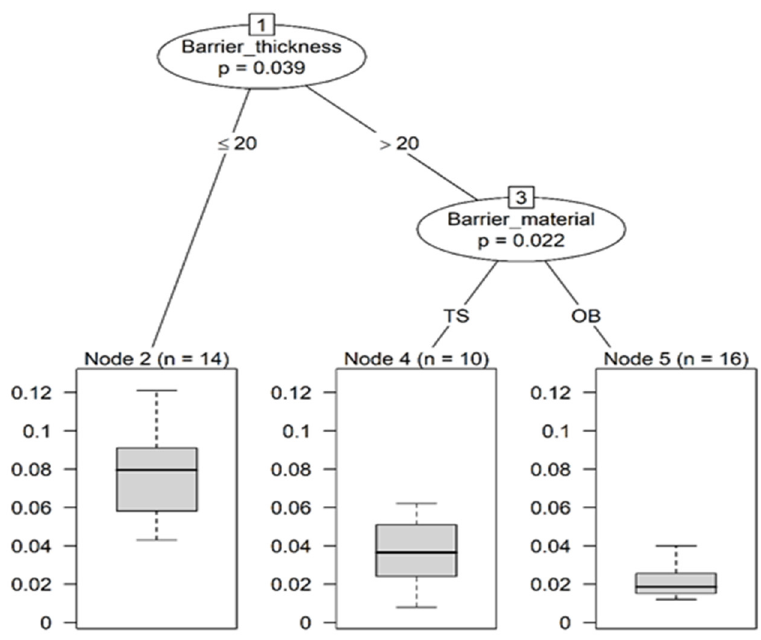
Figure 7. The CIT model for average TDS in the cover soil (PMM) (average TDS are 0.078%, 0.037%, and 0.021% in Node 2, 4, and 5 branches, respectively).